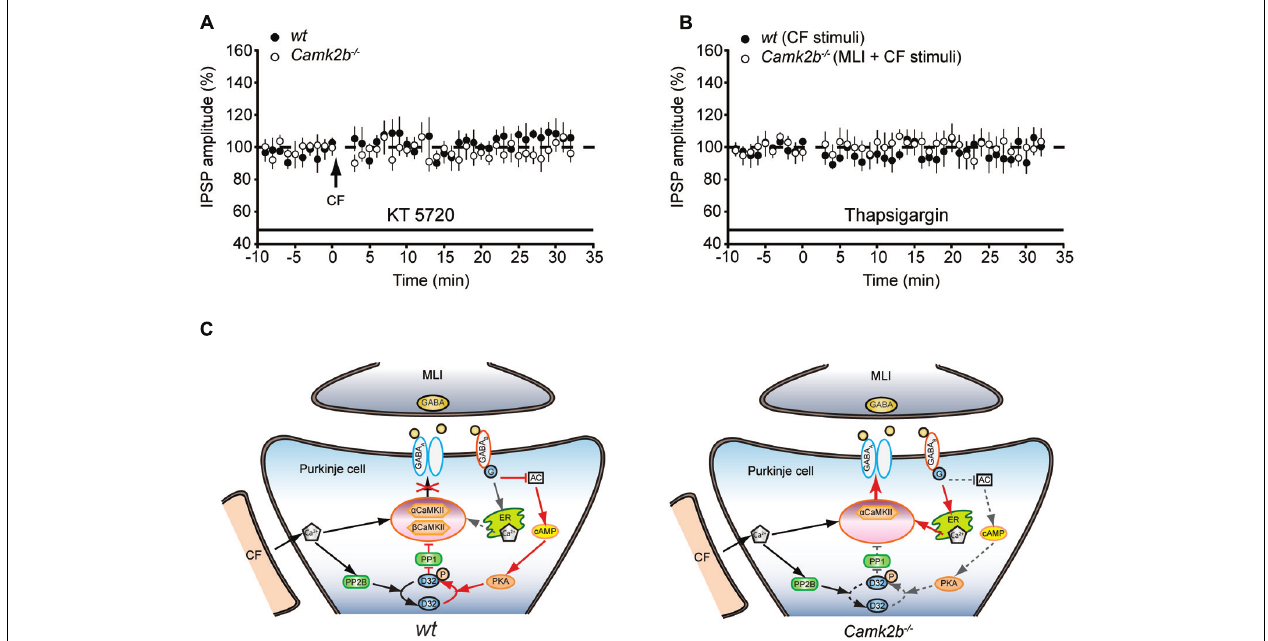
FIGURE 4 | GABA B -receptor activationmay operate two distinct pathways to activate or inhibit the iLTP induction. (A) Left, schematic representation of the working model of CaMKII mediated iLTP induction cascade and GABA B -receptor mediated inhibition of iLTP in wt Purkinje cell. The model is proposed based on previous studies (Kano etal., 1996; Kawaguchi and Hirano, 2002) and the current data. Cascades are simplified for the clarity of illustration. Arrows indicate activation cascades, bars indicate inhibitory cascades. Note that in the presence of both α and β CaMKII, the calcium release from internal stores upon GABA B -receptor activation is outcompeted by the suppressing PKA-PP1 pathway (dashed arrow). AC, adenylyl cyclase; D32, DARPP-32. Right, schematic representation of the CaMKII mediated iLTP induction cascade and GABA B -receptor mediated inhibition of iLTP in Camk2b − / − Purkinje cells.